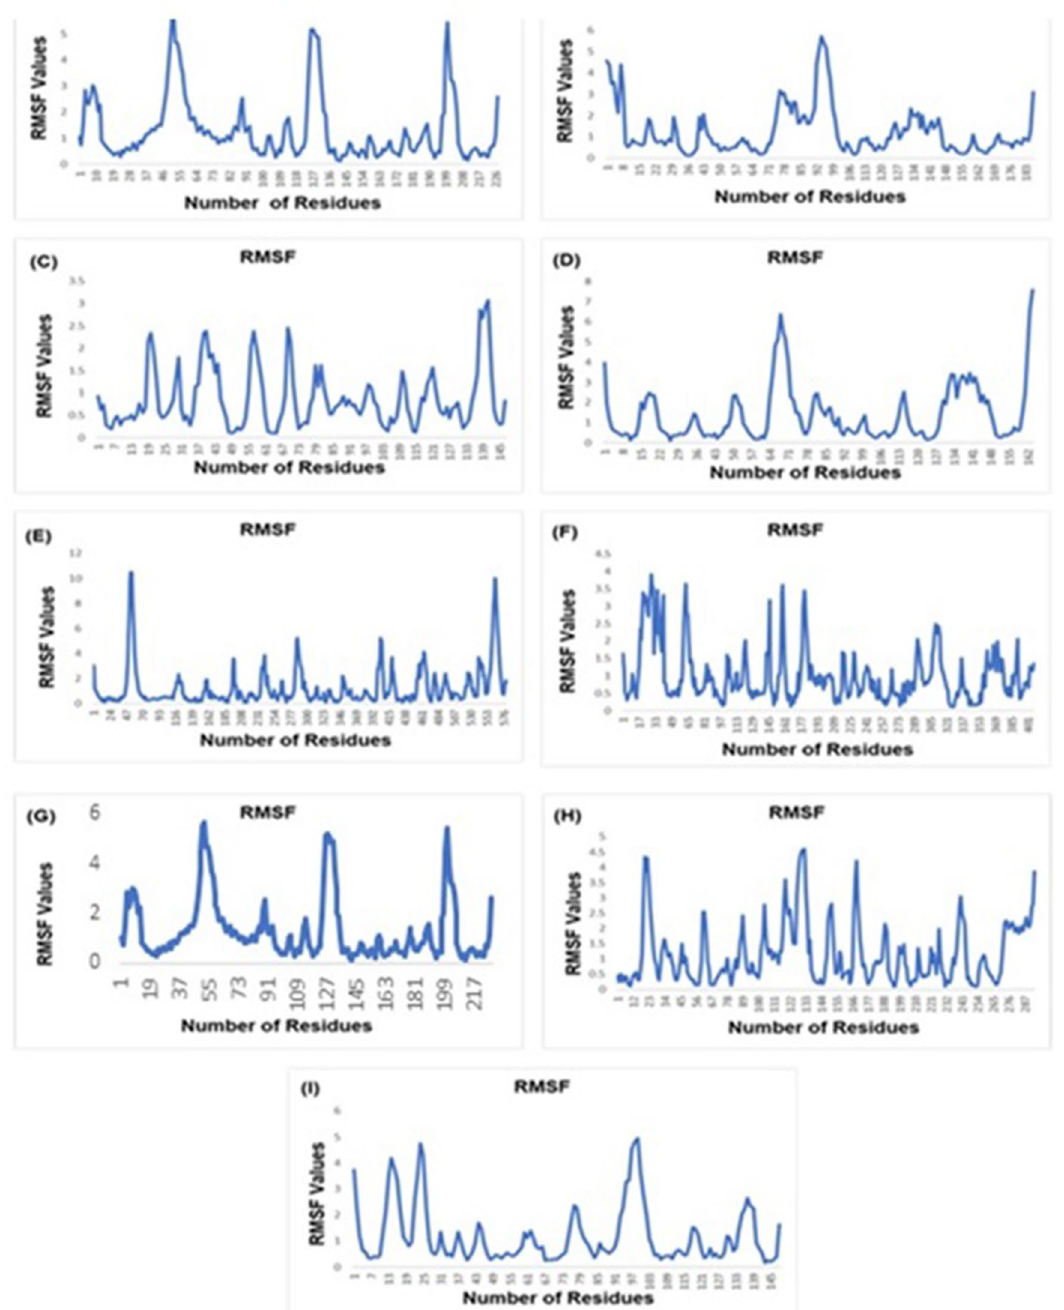
Figure 13. The RMSF plot of all the system trajectories. ( A ) COX2 ( B ) GPx, ( C ) IL-1 ( D ) SOD, ( E ) STAT3, ( F ) iNOS, ( G ) NF-κB, ( H ) p65 and ( I )